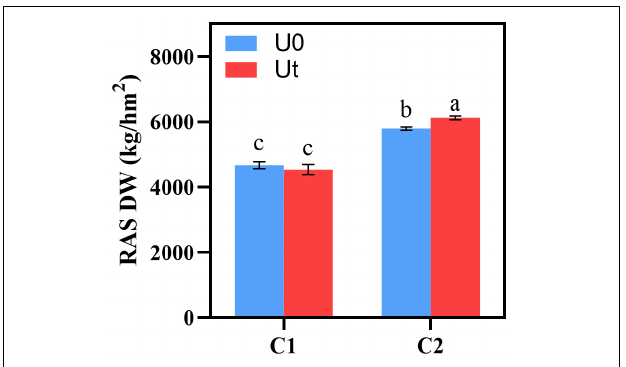
FIGURE 2 | Biomass of two Angelica sinensis cultivars in response to enhanced UV-B radiation. Different letters indicated the significant difference ( P < 0.05). Error bars were represented standard deviation